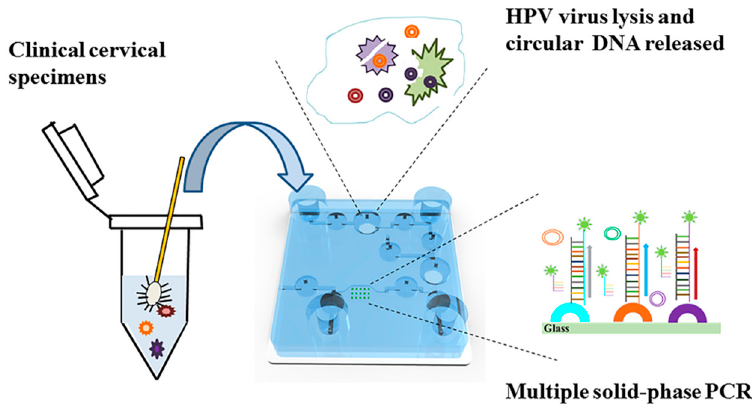
Figure 2. A schematic of the integrated microfluidic chip used for genotyping high-risk human papillomavirus (HPV) strains from clinical samples.